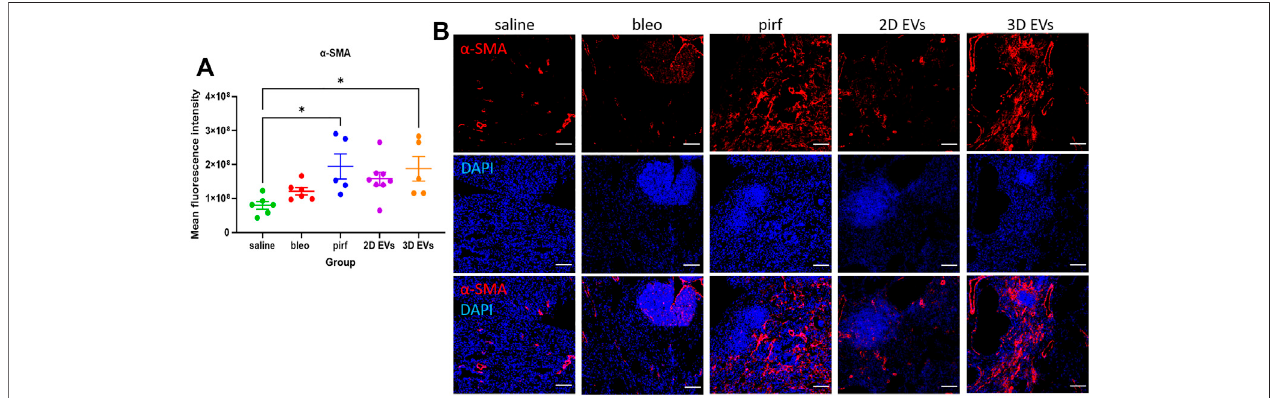
FIGURE 7 | Representative immuno fl uorescence images of α -SMA (red) staining in lung tissues at D28. (A) Mean fl uorescence intensity for a-SMA. (B) Nuclei stainingperformedwithDAPI(blue).TheareawithDAPIclustersdemonstrated thepresenceofin fl ammatoryand fi broblasticin fi ltrateofthelung.Datarepresentmean± SEM, n = 5-8 per experimental group; each symbol represents 1 animal, one-way ANOVA followed by Tukey ’ s post hoc test for multiple comparisons, * p < 0.05. Scale bar is 100 µm.